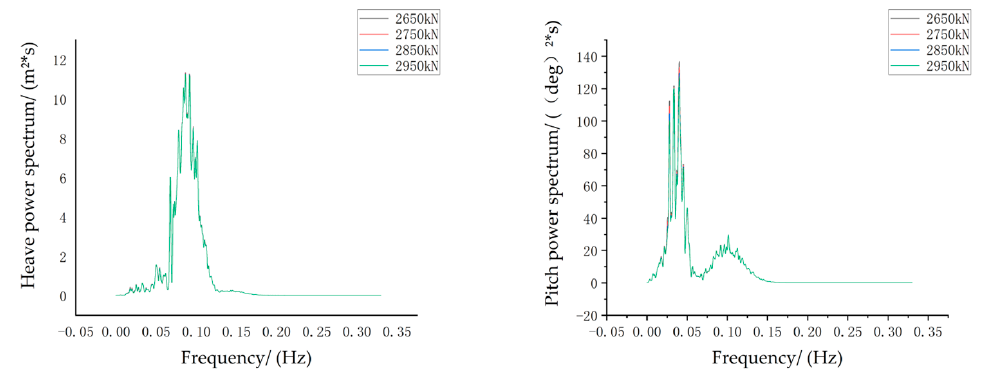
Figure 9. Frequencydomaincomparisonunderdifferentropepretensionsinstormself-survivalconditions. Figure 9. Frequency domain comparison under different rope pretensions in storm self-survival conditions. Table 13. Response RMS of different rope pretensions under storm self-survival conditions. Surge (m) Heave (m) Pitch